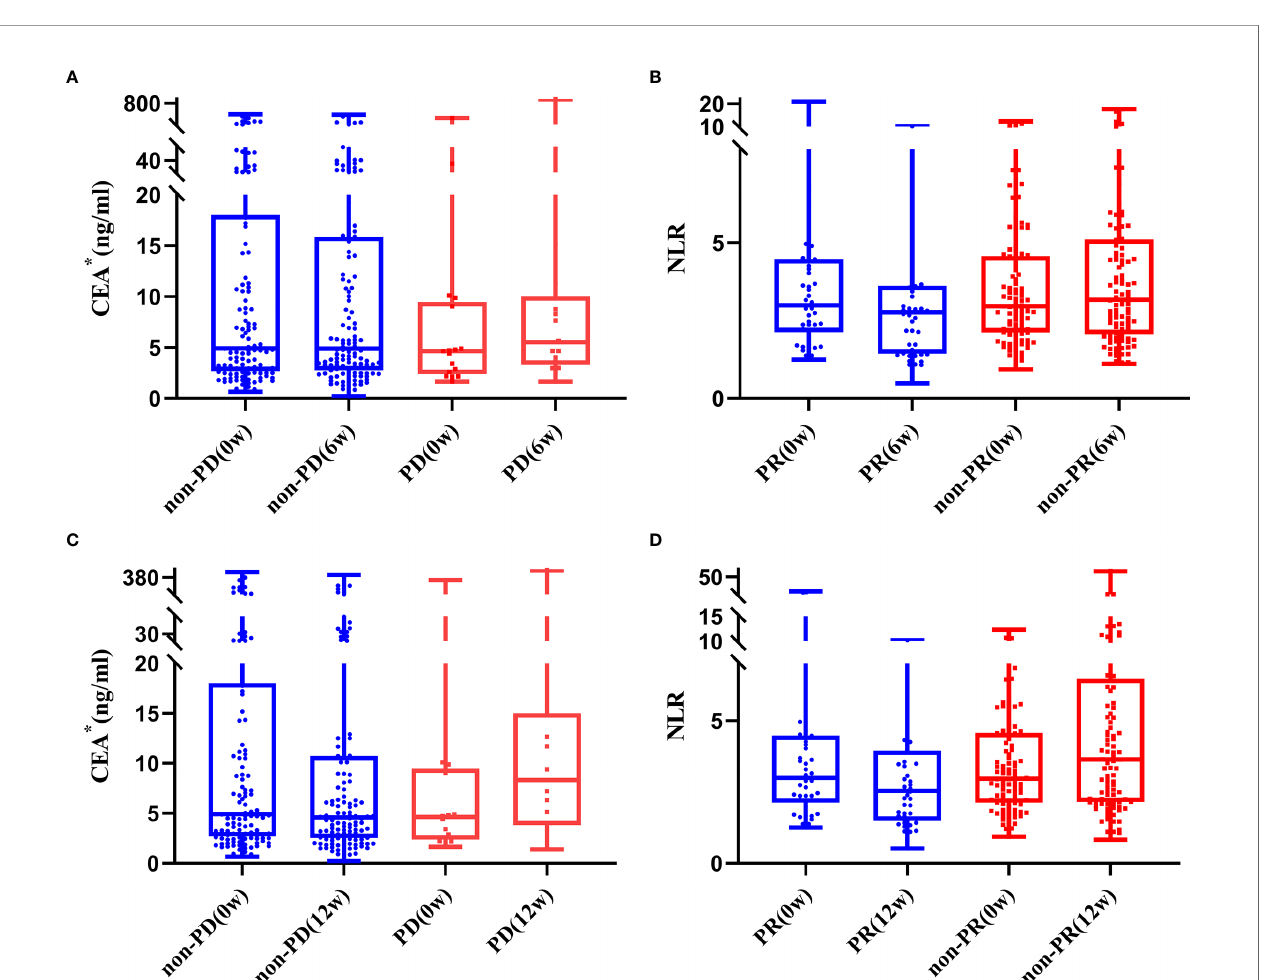
FIGURE 1 | Trend of CEA (A, B) and NLR (C, D) in patients with and without response to treatment (*one extreme value was